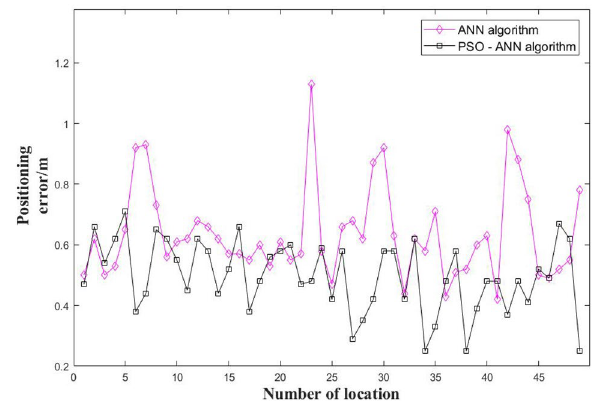
Figure 15. Error comparison of the two positioning algorithms.